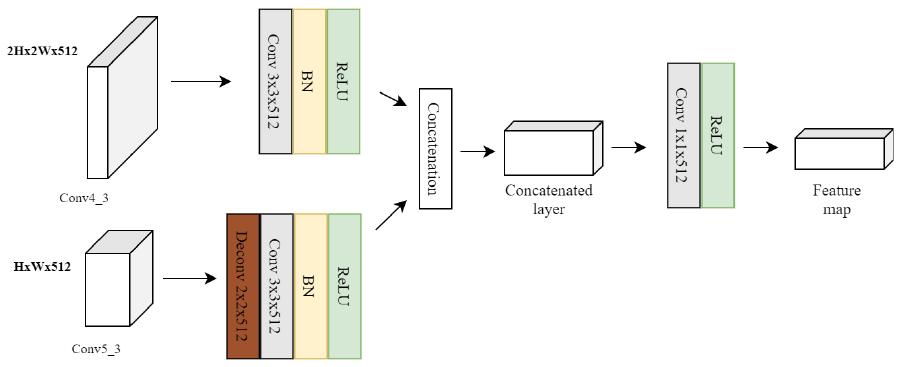
Figure 8. Concatenation of the Conv 4_3 and Conv 5_3 feature